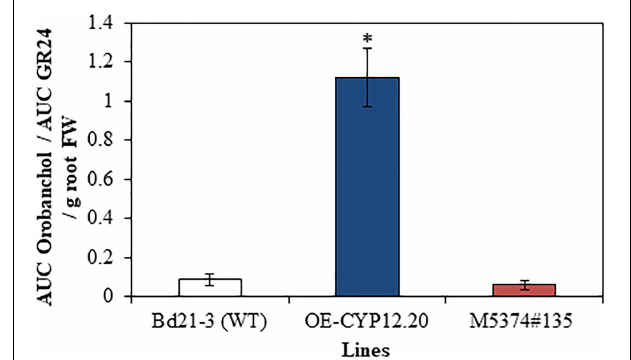
FIGURE 5 | Quantification of orobanchol in B. distachyon exudates. Relative quantification of orobanchol in root exudates of WT (Bd21-3), overexpressing (OE-CYP12.20), and mutant (M5374#135) lines after 7 days of phosphorus starvation. AUC, Area under the curve. MRM transitions 321 > 224 and 347 > 97 were used to quantify GR24 and orobanchol signals, respectively. Mean of three biological replicates ± standard deviation. The asterisk indicates significant differences between conditions ( p- value < 0.05, Tukey’s